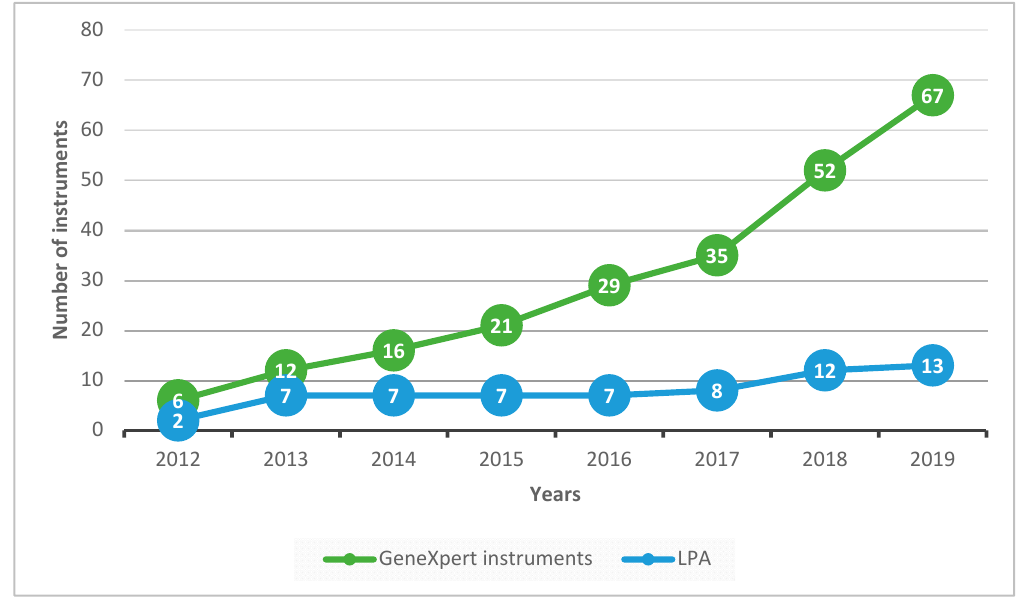
Figure 2. GeneXpert and LPA instruments cumulatively deployed in Uzbekistan from 2012 to 2019. LPA = line probe assay.